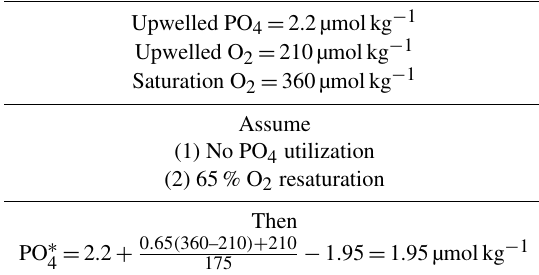
Table 1. Expected Southern Ocean surface PO ∗